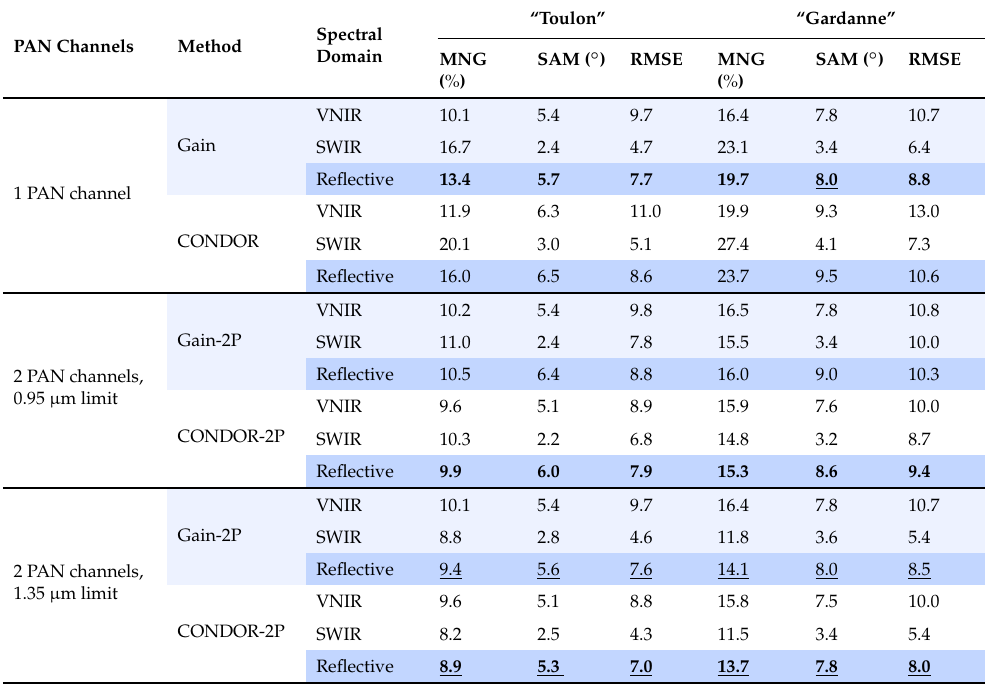
Table 3. “Toulon” and “Gardanne” datasets: quality criteria calculated on transition areas. The optimal values are in bold (by comparing the methods) and underlined (by comparing the PAN